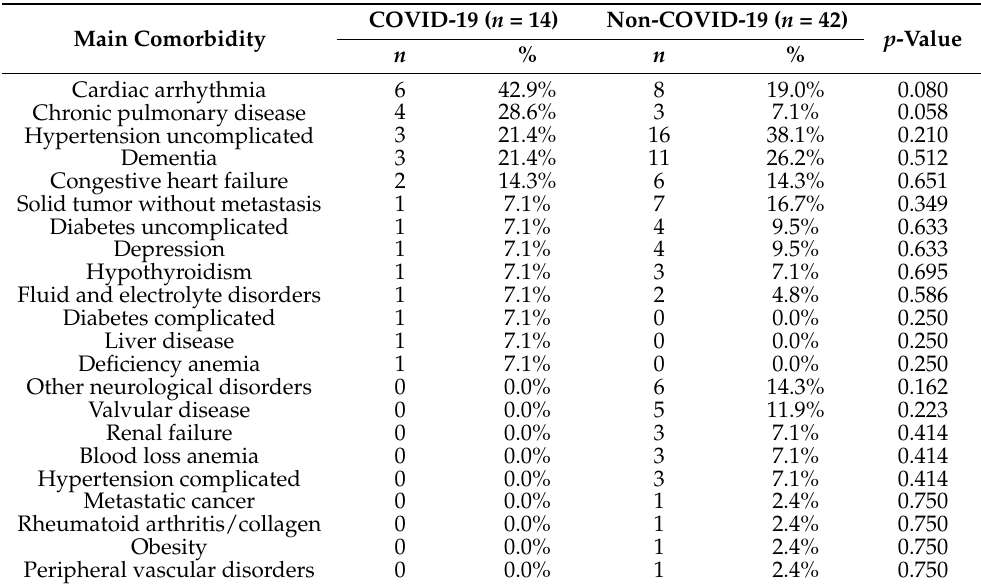
Table 2. Type of comorbidities (as defined by the Elixhauser Comorbidity Index) for cases and